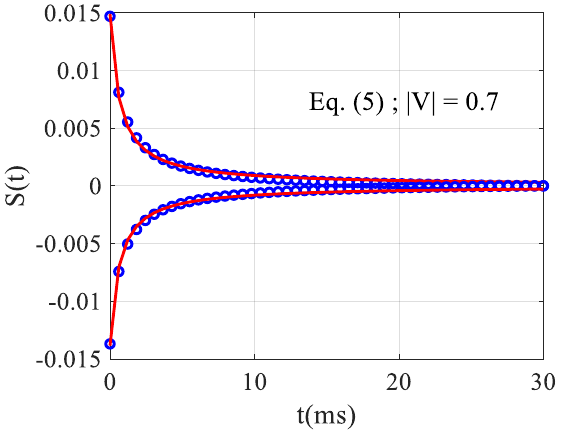
Figure 6. Nonlinear fit (solid red lines) of S(t) showing the temporal evolution of the exact numerical data (empty blue circles) characterizing the rise and the fall time of the TL effect.